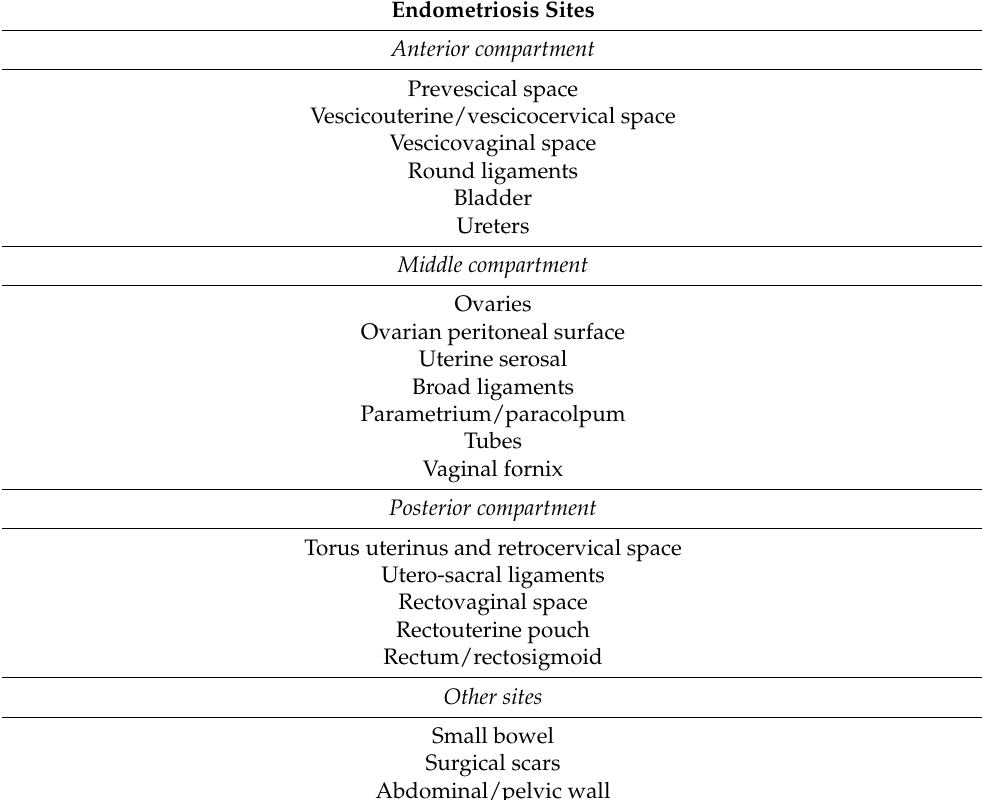
Table 2. Checklist of anatomical pelvic structures used by Readers to assess endometriosis